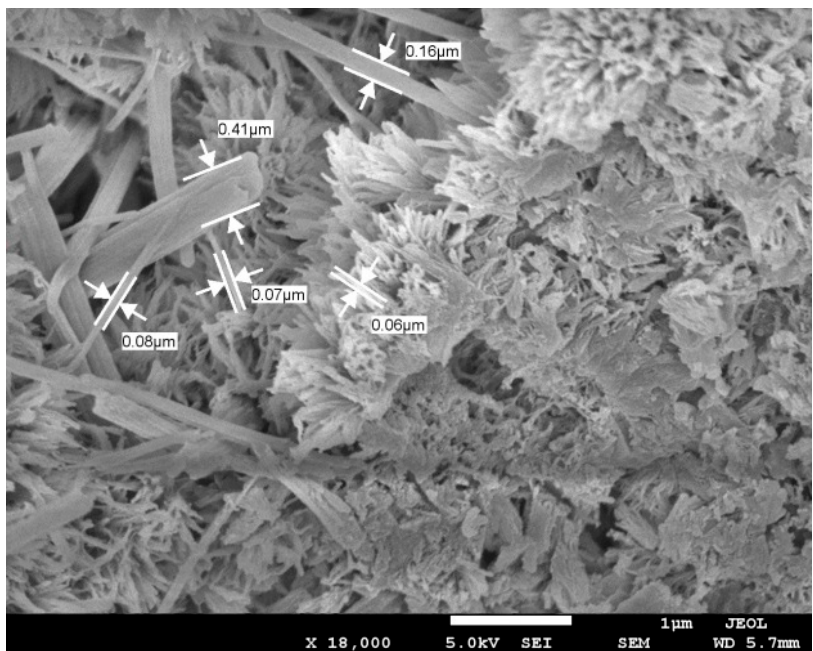
Figure 11. Microstructural image of concrete Mix 7.